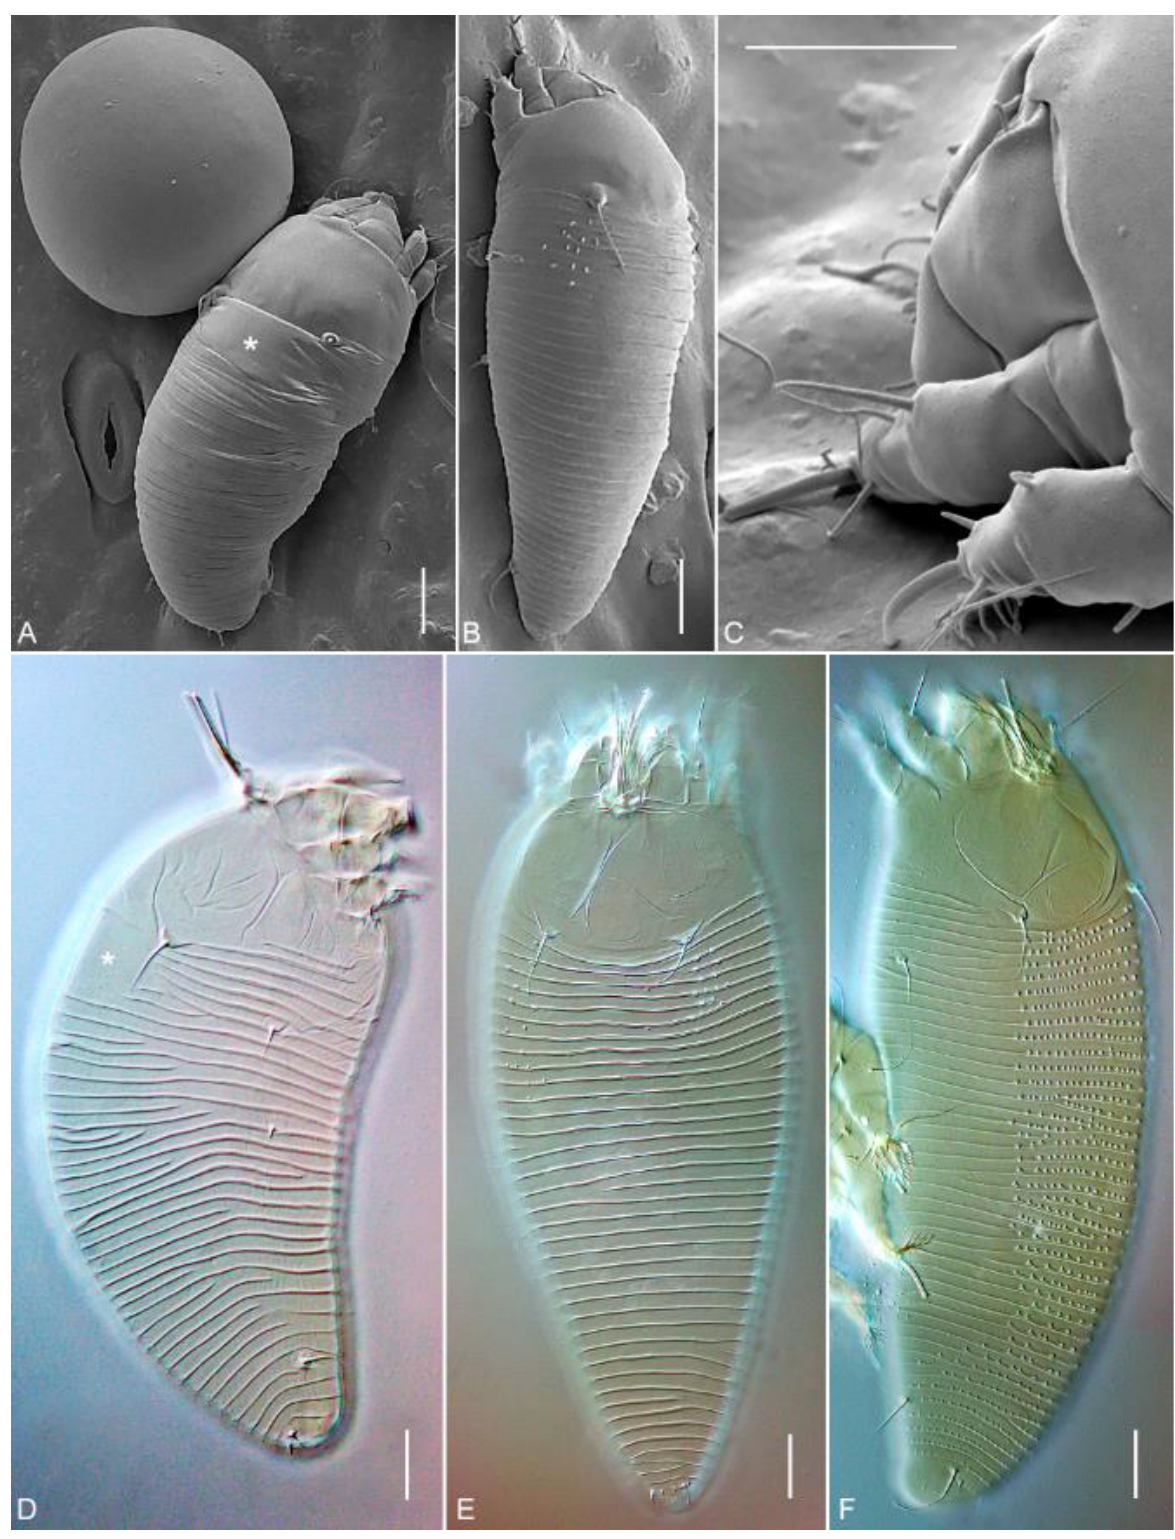
Figure 6. LT-SEM ( A – C ) and DIC LM ( D – F ) images of larvae ( A , D ), morphotype A nymphs ( B , C , E ) and morphotype B nymph ( F ) of Aberoptus schotiae n. sp. Scale bars: ( A , C – F ) = 10 µm; ( B ) = 15 µm. Asterisks indicate cervical pseudotagma.